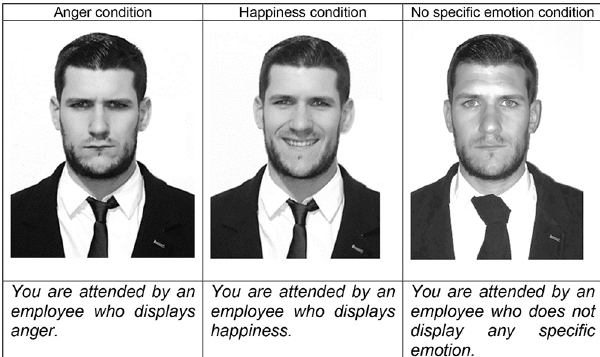
Figure 2. Manipulation of the emotion displayed